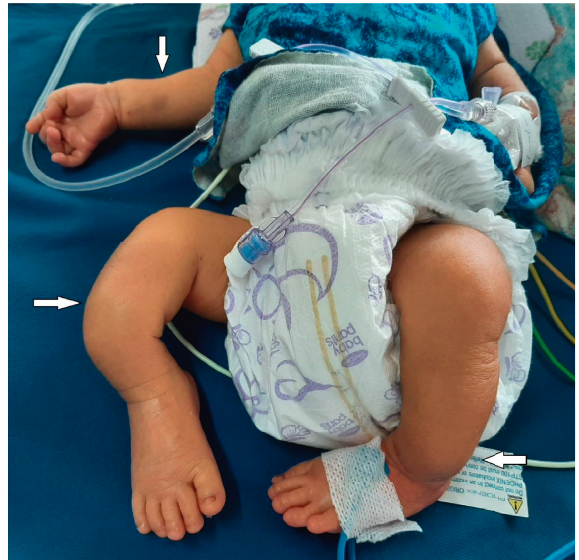
Figure 1: Gross bony deformities present over bilateral upper and lower extremities (shown by arrow head).